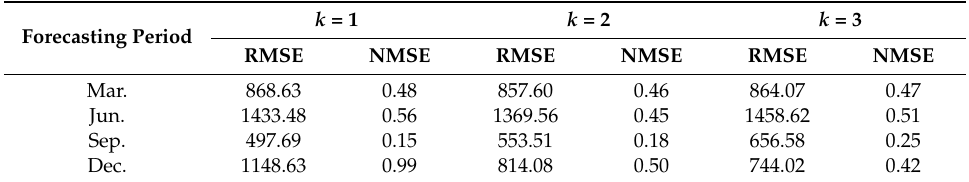
Table 2. Comparison of the errors of different nearest neighbor numbers (the value of k ) in large samples (unit: